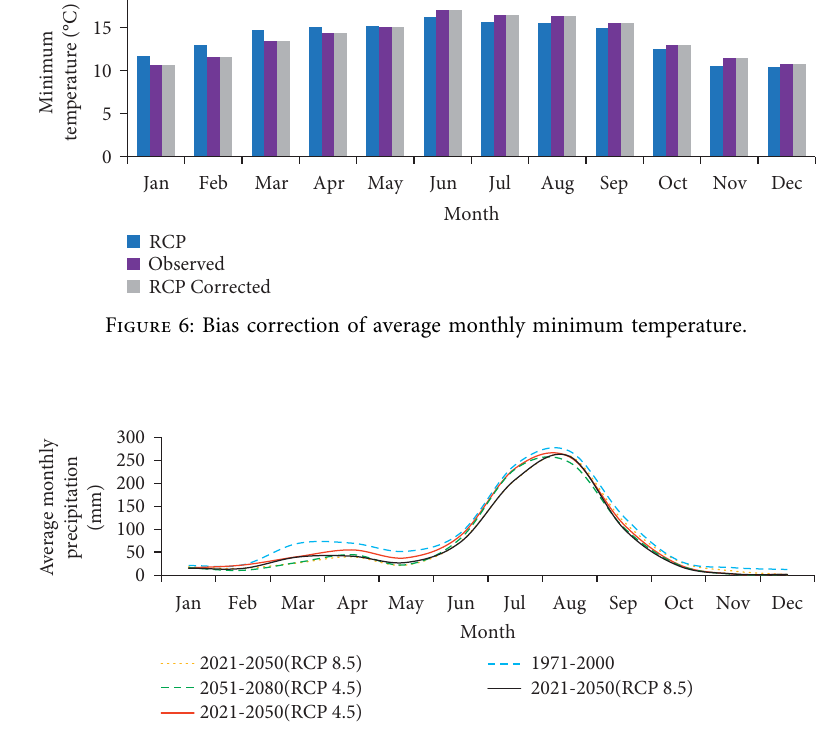
Figure 7: Average monthly precipitation of future scenarios for Kesem